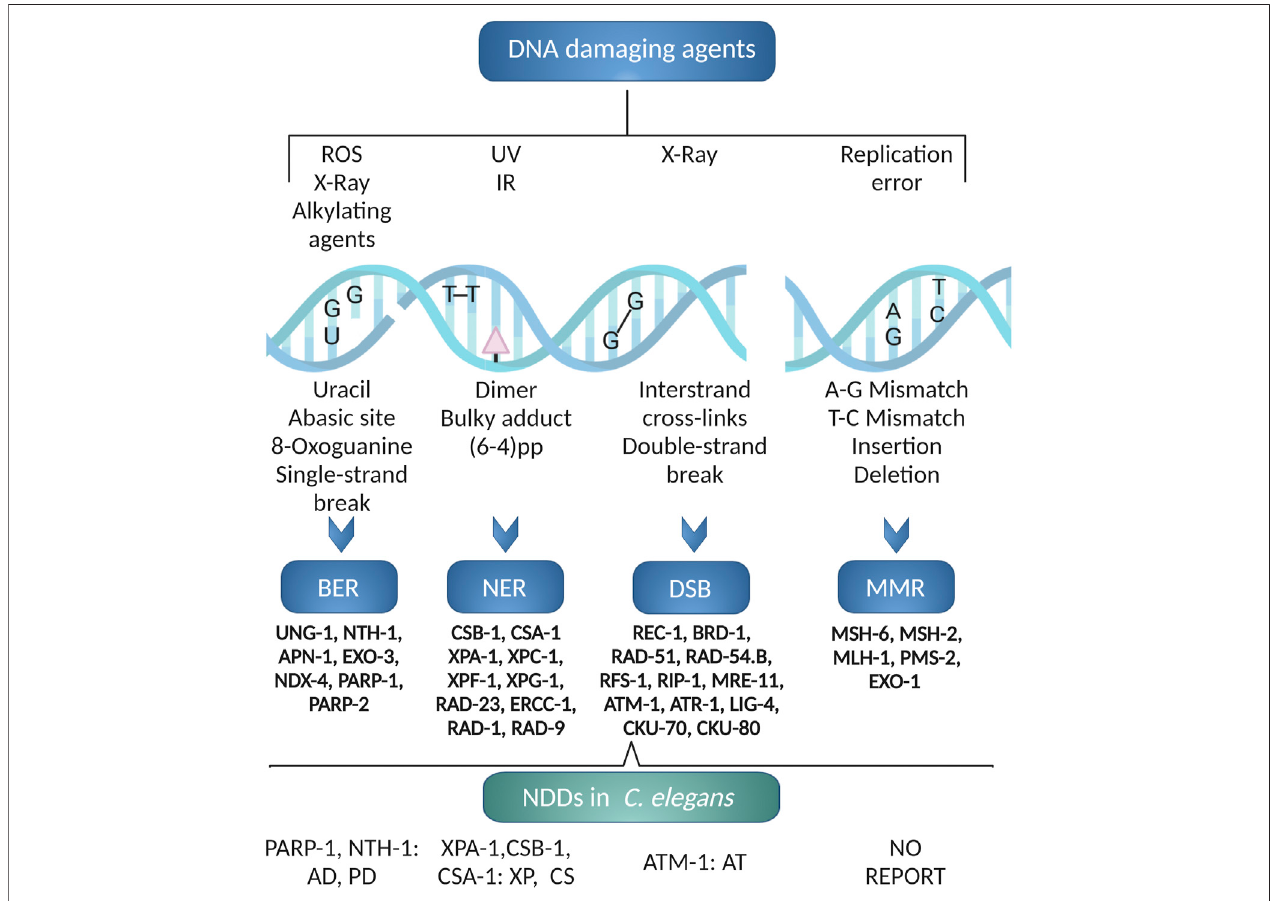
FIGURE 3 | C. elegans DNA repair pathways. The excision repair pathways BER, NER, DSB and MMR are operative in C. elegans . Using C. elegans various neurodegenerative diseases like AD, PD, XP, CS and AT associated to DNA repair defects has been modeled. The fi gure has been generated using Biorender.com by the